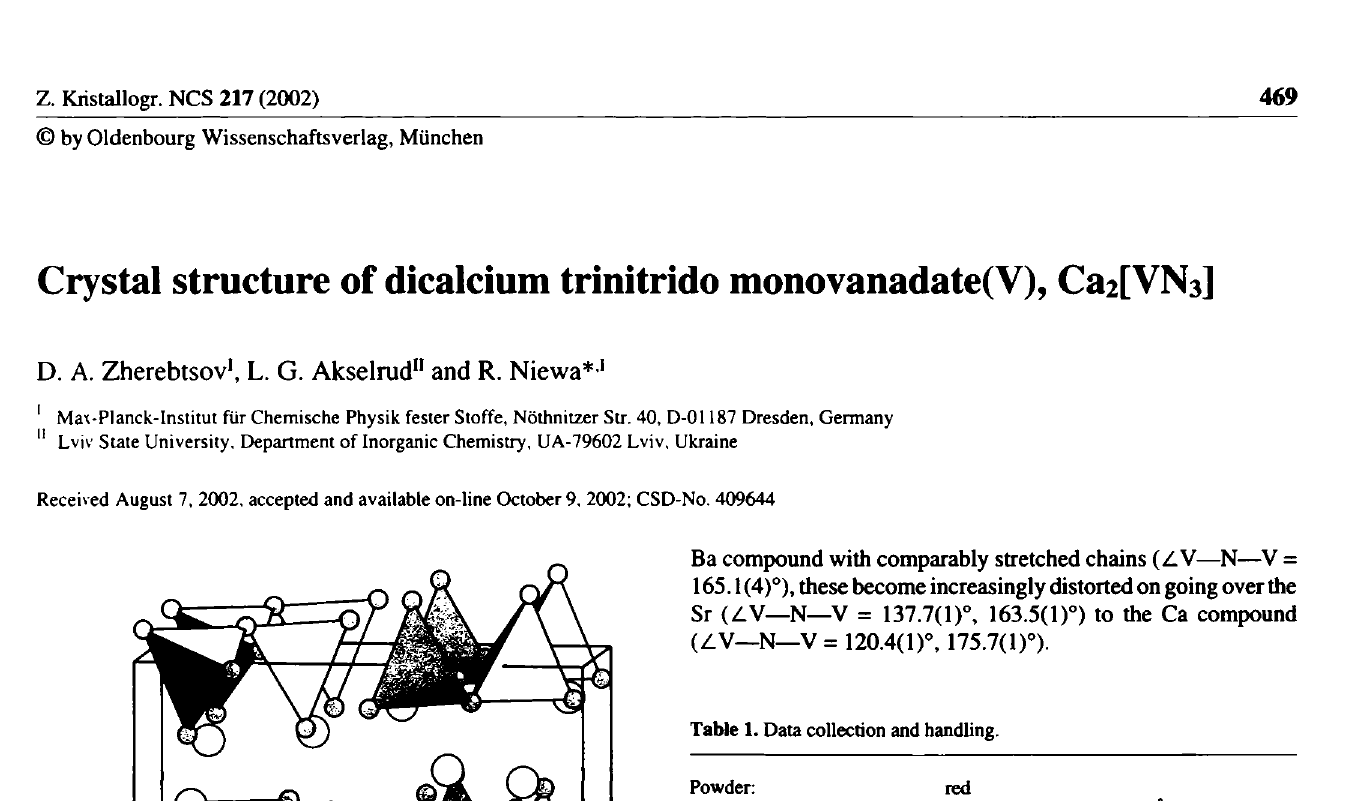
Table 1. Data collection and handling.